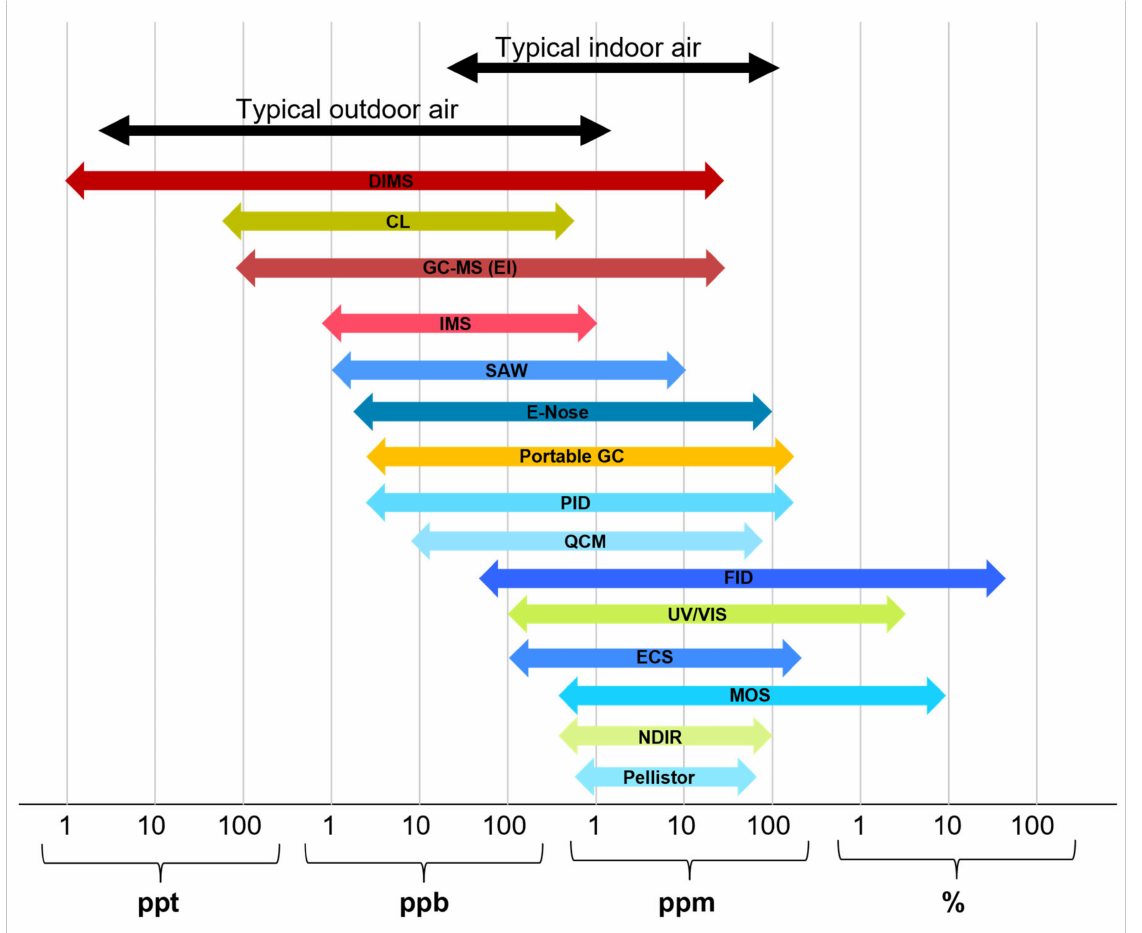
Figure 1. Measurement range of the analytical methods presented in this article compared to typical concentrations of VOCs in indoor and outdoor air. The given ranges are approximations that were compiled from all literature references cited in this article and represent the average properties of the methods which may not be true for every single device that belongs to